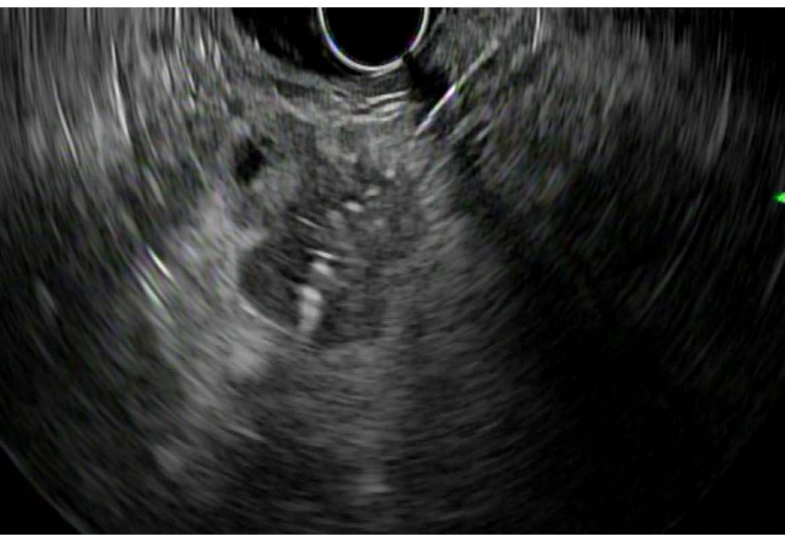
Figure 1. Endoscopic ultrasound-fine needle aspiration (EUS-FNA): Endosonographic image of an EUS-FNA of a pancreatic